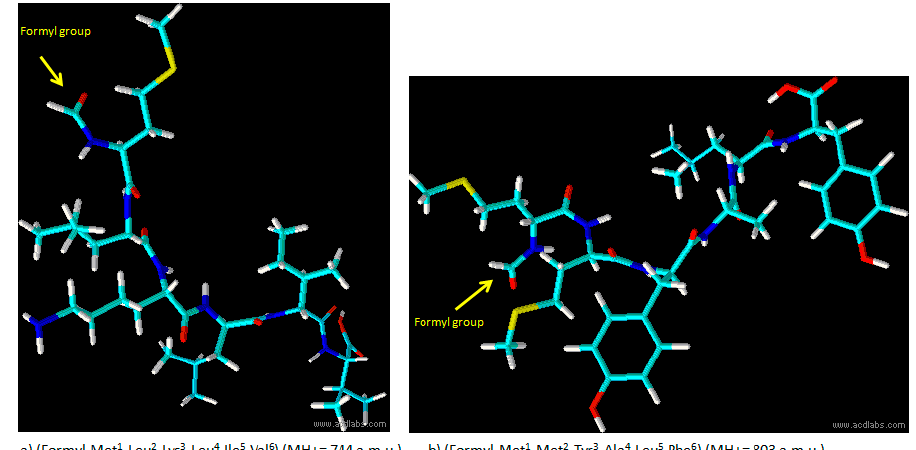
Figure 1. Structure of formylated peptide ( a ) and formylated peptide ( b ).